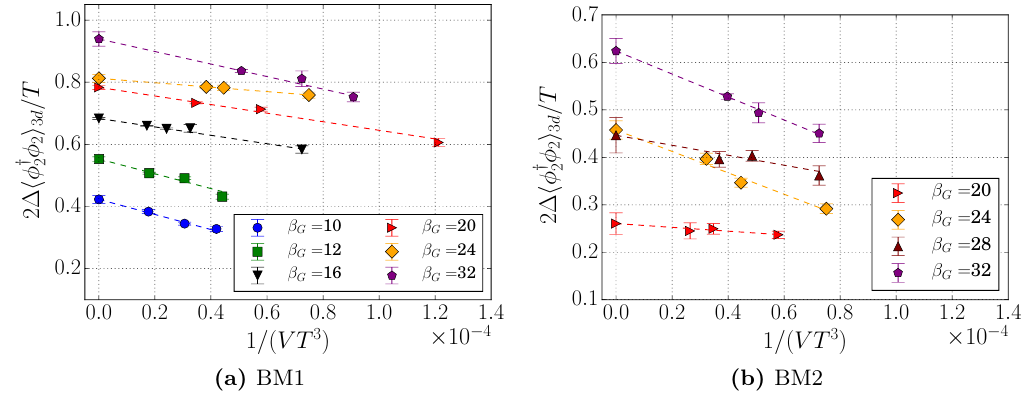
Figure 4. Volume dependence of the order parameter discontinuity 2(cid:1) h (cid:30) y lattice